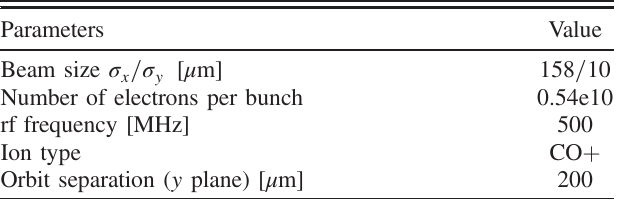
TABLE I. Basic beam parameters of the SSRF storage ring for ion trapping